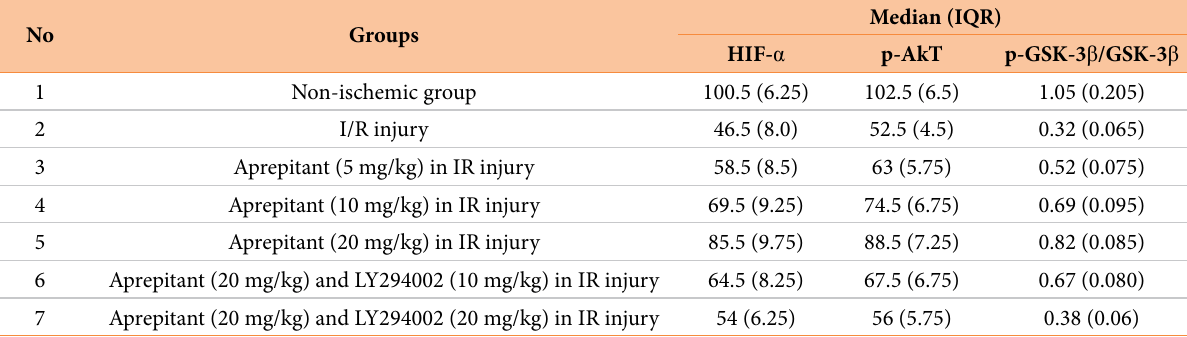
Figure 5 - Effect of aprepitant and LY294002 on ischemia-reperfusion induced changes in p-GSK-3 β /GSK-3 β in the heart homogenate. Values are given as mean ± SD. (a) p < 0.05 vs . non-ischemia; (b) p < 0.05 vs . IR injury; (c) p < 0.05 vs . aprepitant (20 mg/kg). Table 3 - Values of HIF- α , p-AkT and p-GSK-3 β /GSK-3 β in median (IQR) in aprepitant and LY294002-treated animals in ischemia-reperfusion induced